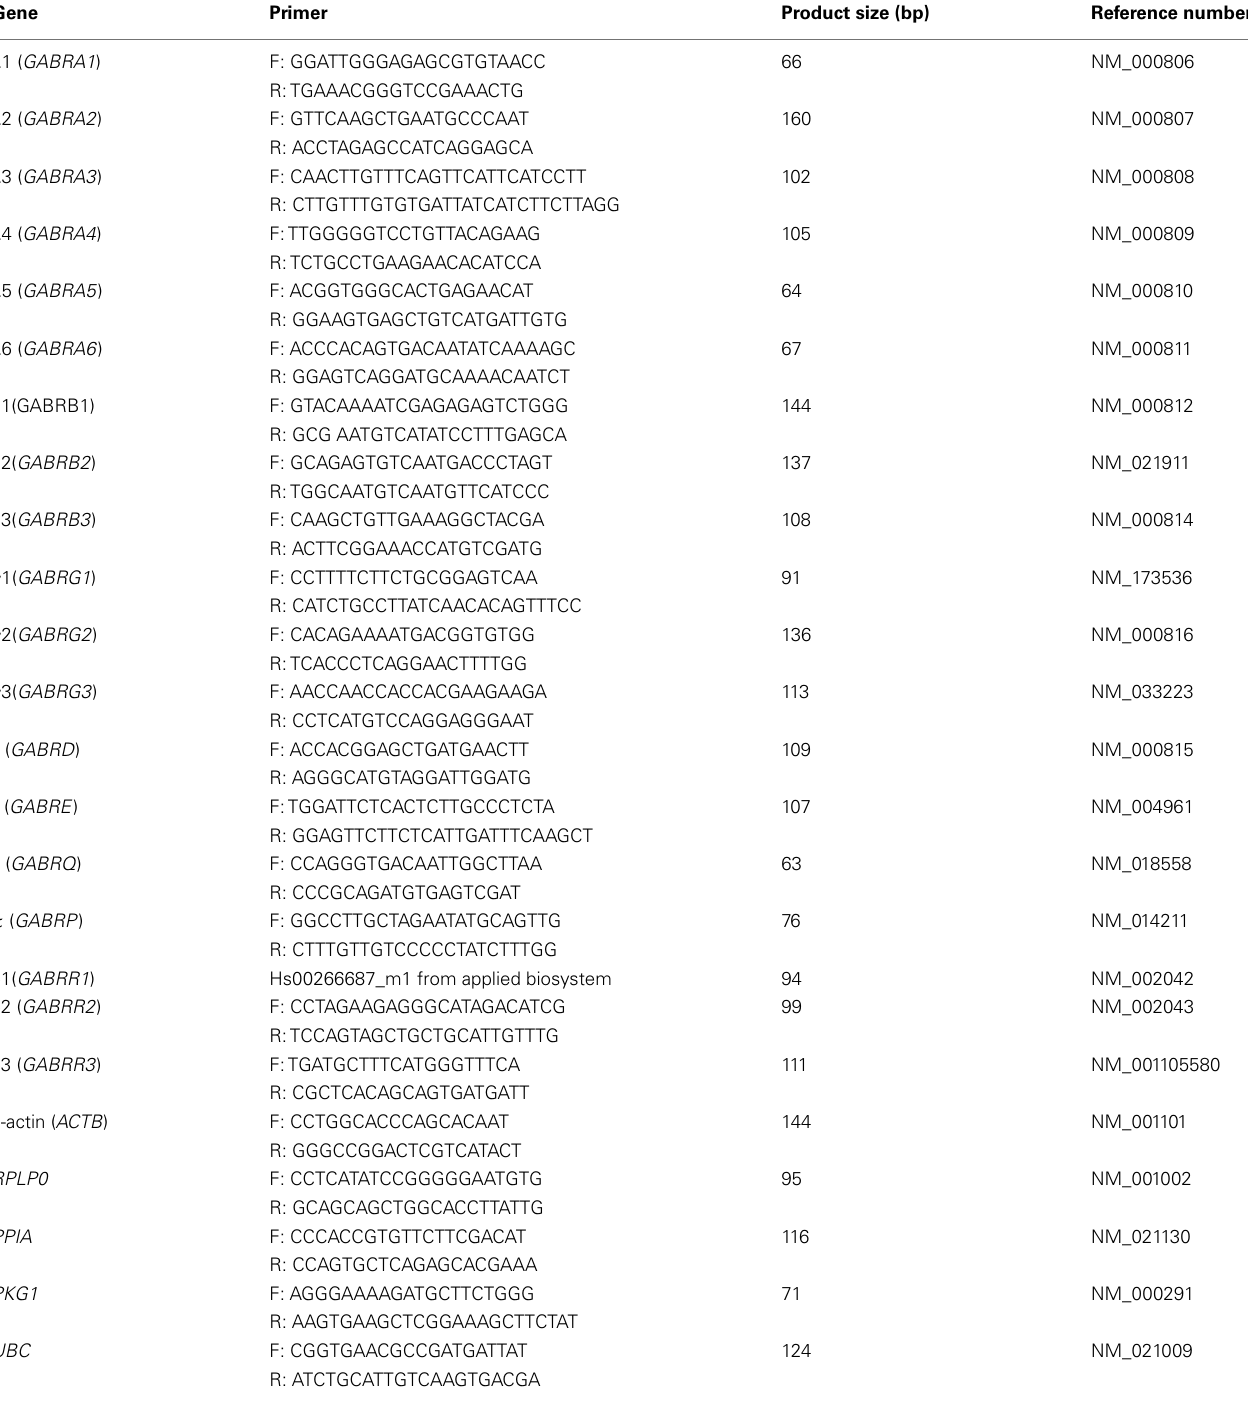
TableA2 | Human primers list for quantitative real-time